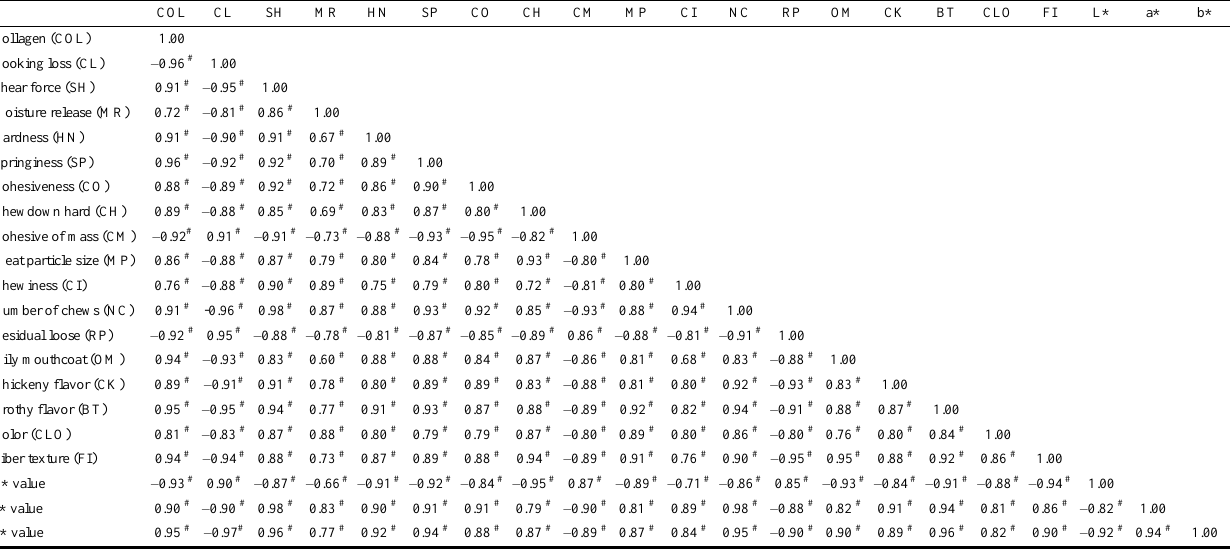
Table 5. Pearson correlations between descriptive sensory attributes and instrumental analysis in Taiwan native chicken breast meat COL